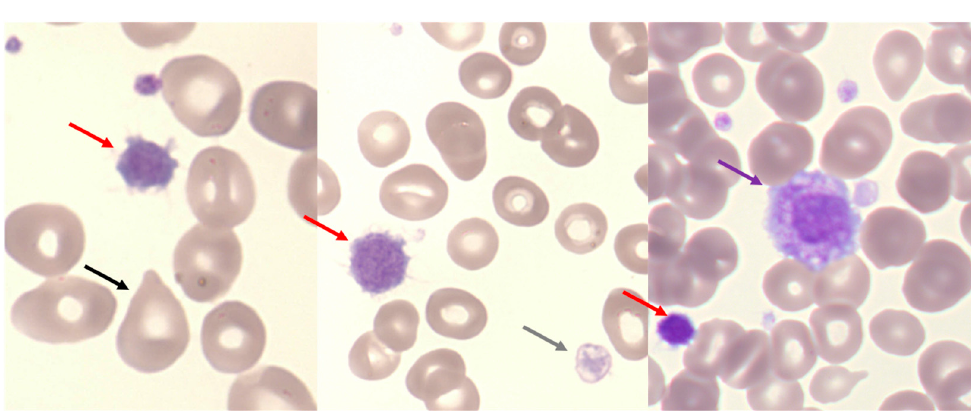
Figure 5. Blood smear in pre-PMF. Heterogeneity of platelets with macroplatelet (red arrows), giant platelet (purple arrow), degranulated macroplatelet (grey arrow) associated with teardrop-shaped RBC (black arrow). (Optical microscopy, May Grünwald Giemsa, ×100 magni fi cation).